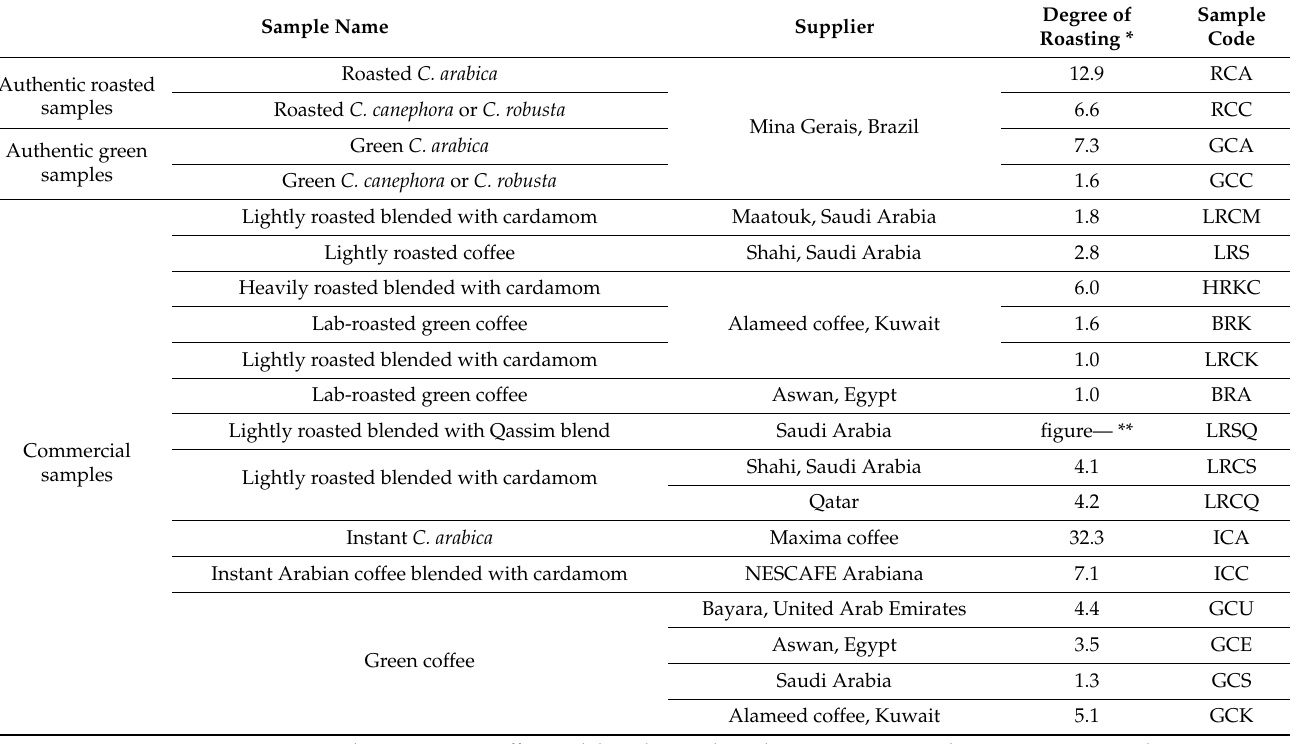
Table 1. A list of coffee specimens analyzed using UHPLC-ESI–HRMS and UV spectroscopy, includ- ing origin, degree of roasting, and the sample code used in the